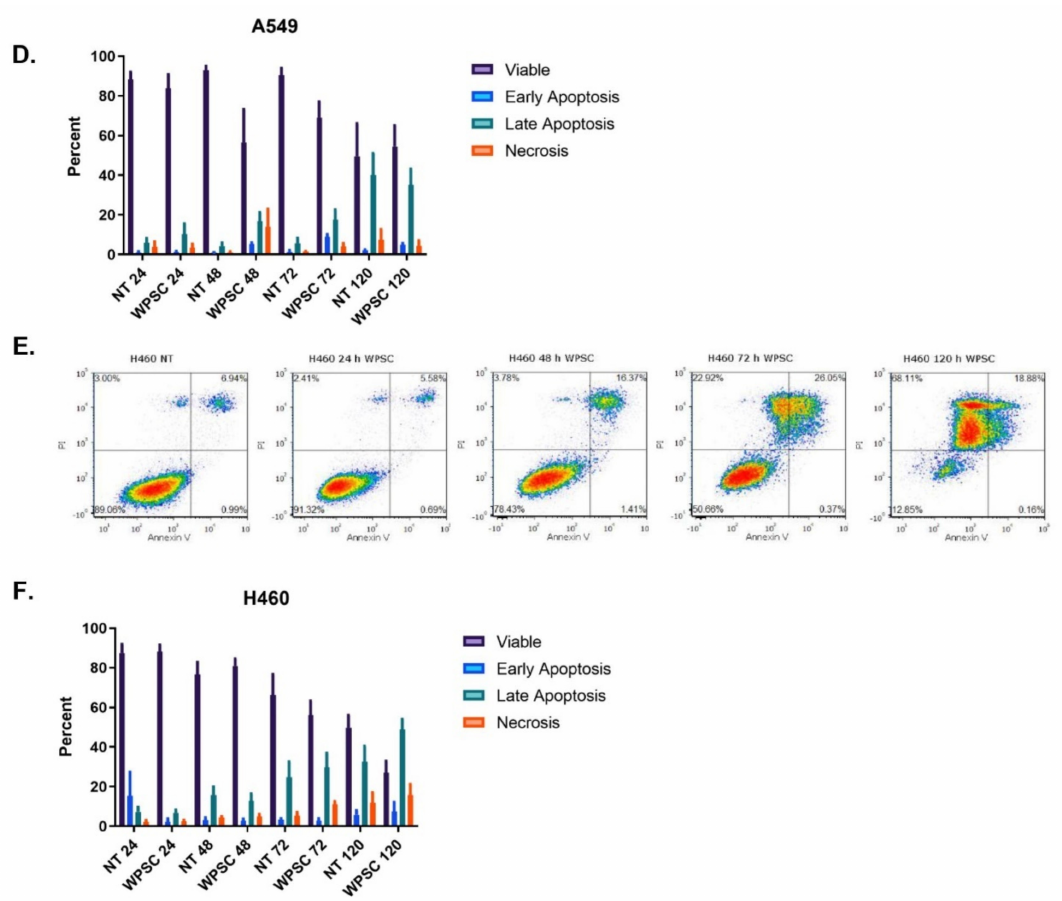
Figure 1. WPSC increases apoptosis and autophagy in lung cancer cell lines. Cell viability in response to 0.5% WPSC was measured using MTT assay in A549 ( A ) and H460 ( B ) cell lines at 24, 48 and 72 h. Apoptosis was measured by flow cytometry. Cells were stained with a combination of Annexin V-FITC, propidium iodide (PI) following WPSC treatment, in A549 ( C , D ) and H460 ( E , F ). Results represent means of three independent experiments, and data represent mean ± standard error of mean. * p ≤ 0.05, ** p ≤ 0.01 and *** p ≤